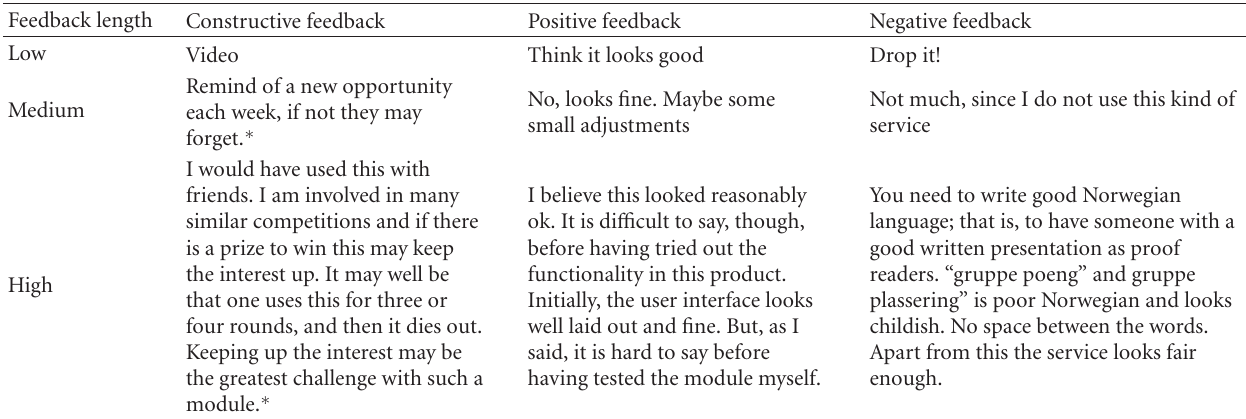
Table 3: Examples of constructive, positive, and negative user feedback; all in response to questions on the improvement of the suggested service. Feedback marked ∗ was related to a just-for-fun betting service proposed in Case